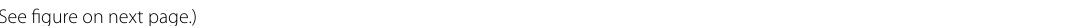
figure on next Fig. 7 Effect of VRP on intracellular free Ca 2 + . Representative fluorescent images from a Normal control, b LPS only, c Morning VRP, d Evening VRP. e Calibrated intracellular free Ca 2 + , data are expressed as the mean SD and were analyzed using one-way ANOVA followed by Tukey post hoc test. ± Values were considered significantly different at P < 0.05. a: significant versus normal control, b: significant versus LPS only, and c: significant versus morning VRP. LPS: lipopolysaccharides, VRP: